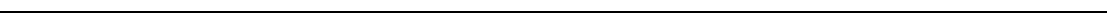
Fig. 7 Chemogenetic inhibition of NAc D 1 R neurons increases NREM sleep and promotes nest-building. a Drawings of superimposed AAV injection sites in the NAc of D 1 R-Cre mice ( n = 9, indicated with different colors). b Representative traces showing that CNO decreased the number of evoked action potentials in an hM4Di-expressing neuron. c Time course of wakefulness, NREM sleep, and REM sleep after administration of vehicle or CNO at 09:00 ( n = 9, repeated-measures ANOVA; F = 26.7 (wake), 24.9 (NREM), 0.3 (REM); P = 8 × 10 − 5 (wake), 1 × 10 − 4 (NREM), 0.6 (REM)). d Total amounts 1,16